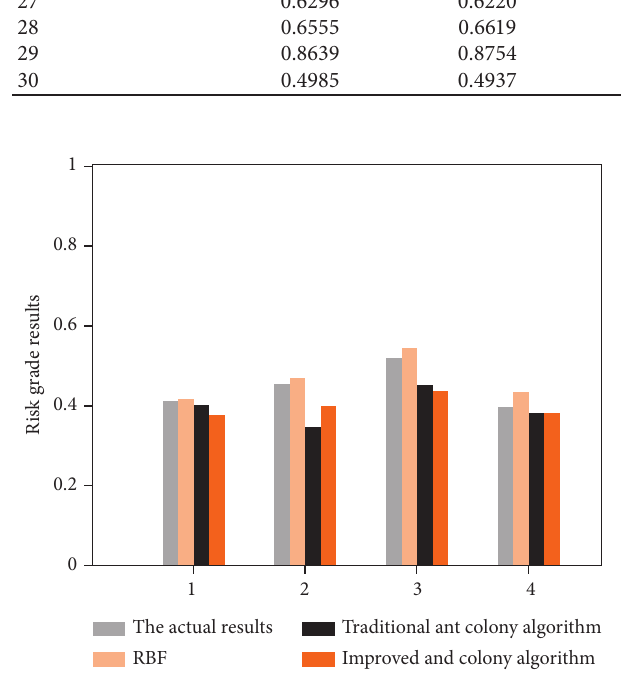
Figure 5: The actual value compared with the predicted